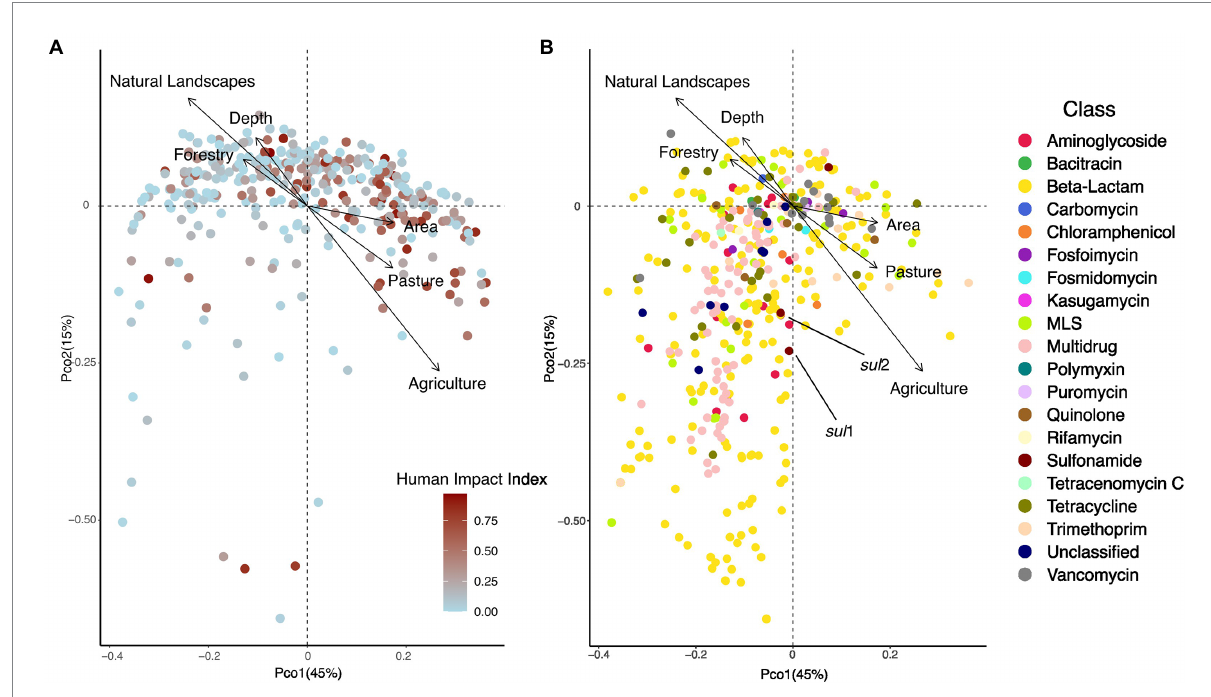
FIGURE 3 (A) PCoA showing the distribution of 349 lake samples projected in the first two dimensions. Each sample is colored by its human impact index (HII, see text). Arrows show variables that significantly correlated with the ordination after environmental fitting (tested variables: fraction agriculture, pasture, mining, urban, forestry, natural landscapes in the watershed). (B) PCoA showing the distribution of individual resistance genes ( N = 468) projected in the first two dimensions. Each resistance gene is colored by its class. Arrows show variables that significantly correlated with the ordination after environmental